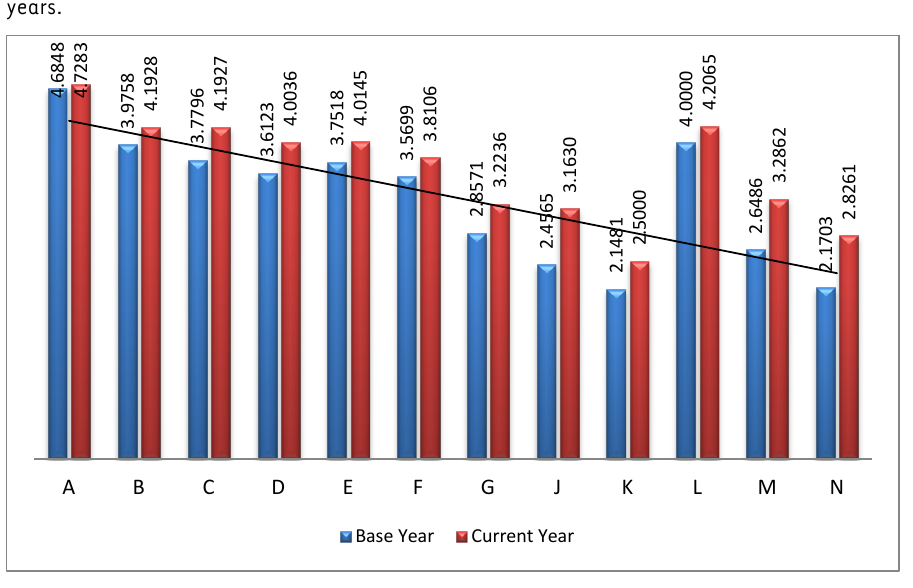
FIGURE 3: Level of reporting by existing indicators Source: Authors’